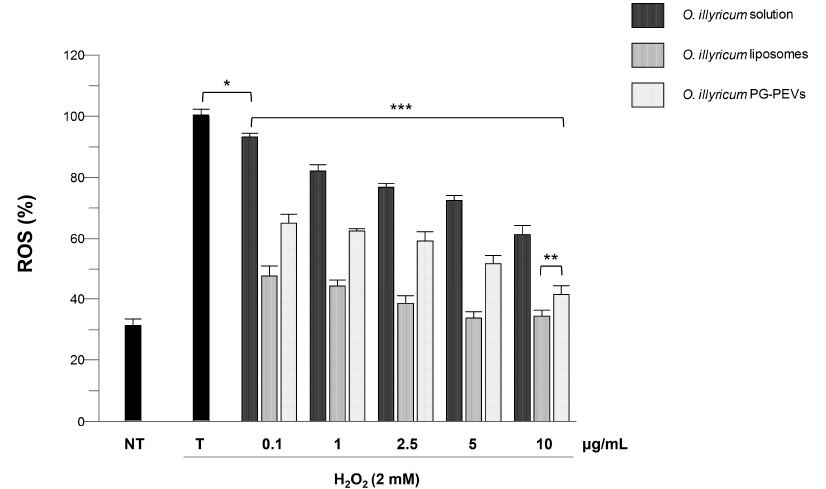
Figure 3. Inhibition of H 2 O 2 -induced ROS generation (1 h-incubation with 2 mM H 2 O 2 ) by O. illyri- cum solution and O. illyricum liposomes/PG-PEVs in HaCaT cells. NT, non-treated cells; T, cells treated with H 2 O 2 only. *** Values statistically different ( p < 0.0001) from each other and from cells treated with H 2 O 2 only (T), with the exceptions of 0.1 μ g/mL O. illyricum solution vs. cells treated with H 2 O 2 only (* p < 0.05) and 10 μ g/mL O. illyricum liposomes vs. PG-PEVs (** p < 0.005).